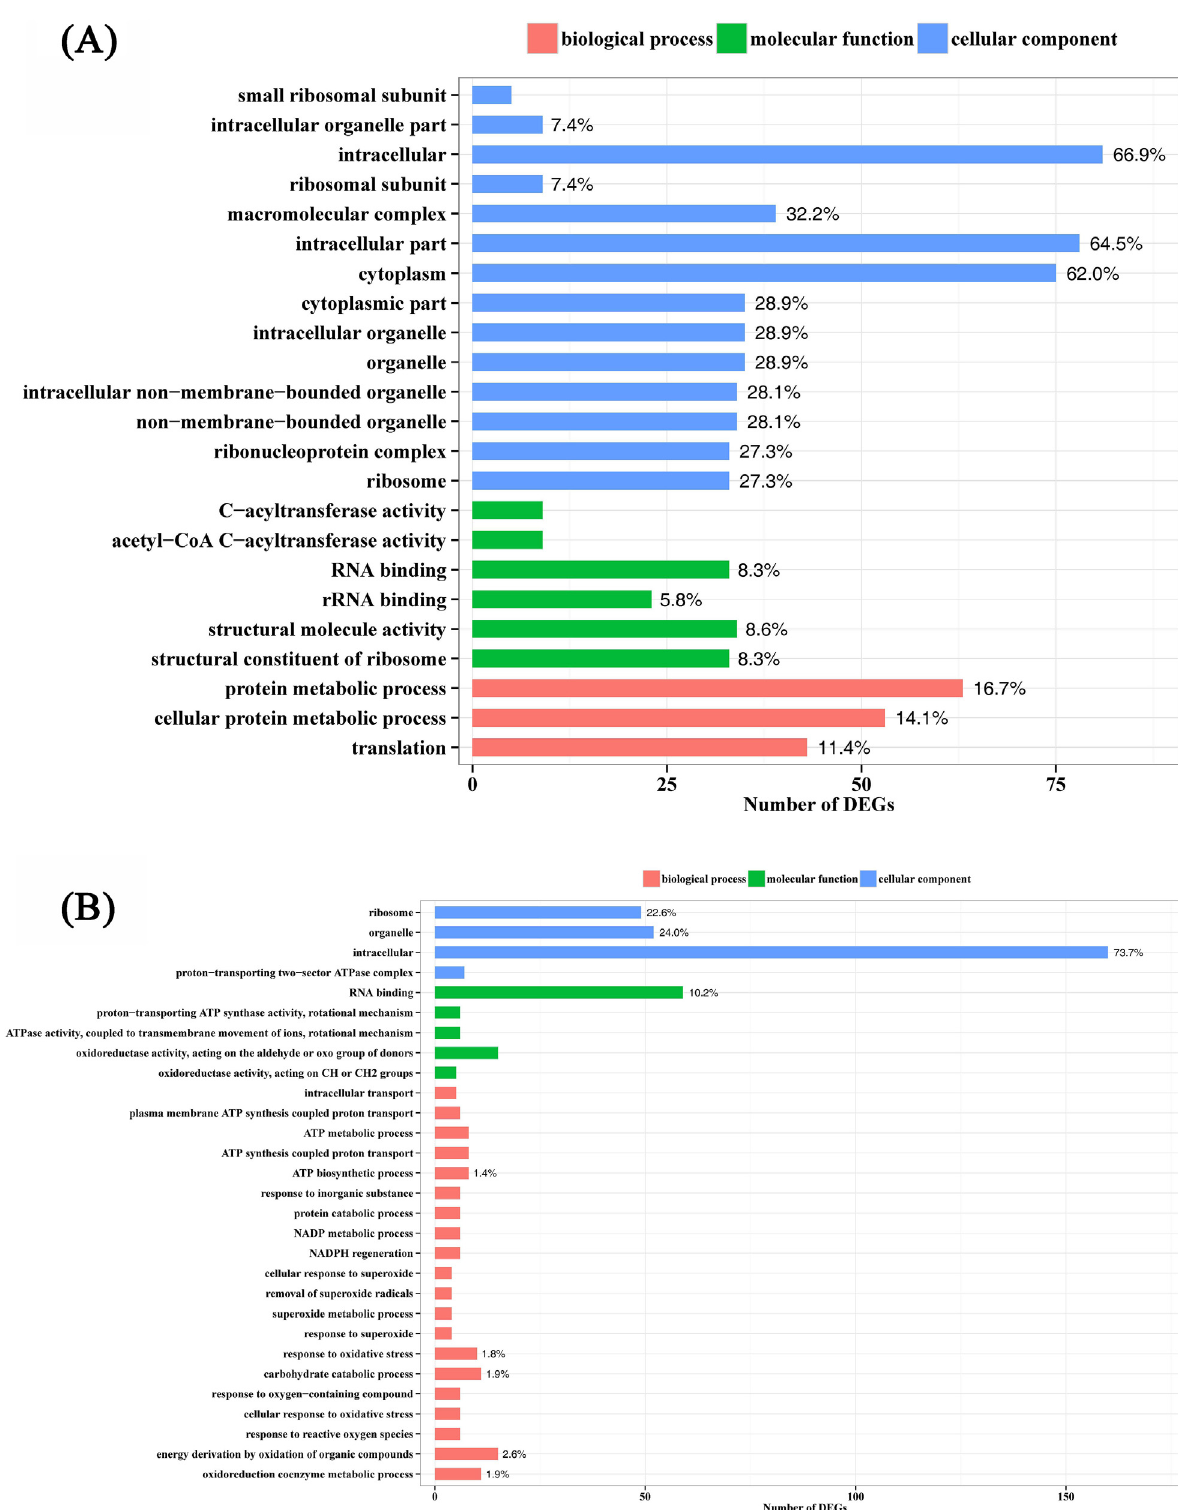
Fig 4. Significant enriched GO terms of differentially expressed genes in Rhodococcus sp. strains TG13 (A) and TN3 (B). The y-axis denotes the number of genes in a category. The number above the bar denotes the percentage of a specific term of genes in the main category.